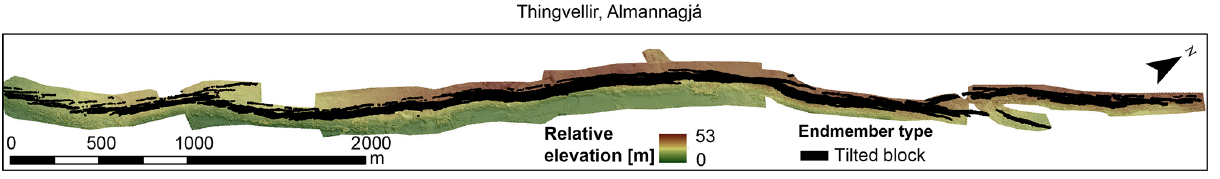
Figure 19. DEM and proposed endmember types of the fractures of the Thingvellir fissure swarm. Projection of the DEM: WGS1984 UTM